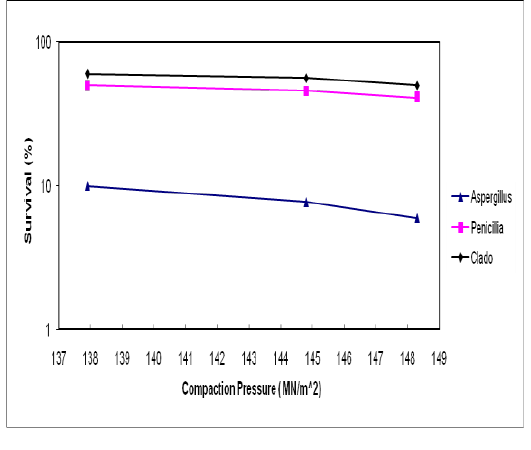
Figure 1 : effect of compression pressure upon the survival of ( 10 2 spore/gram ) different fungal spores in Multivitamin tablet L.S.D = 3.7